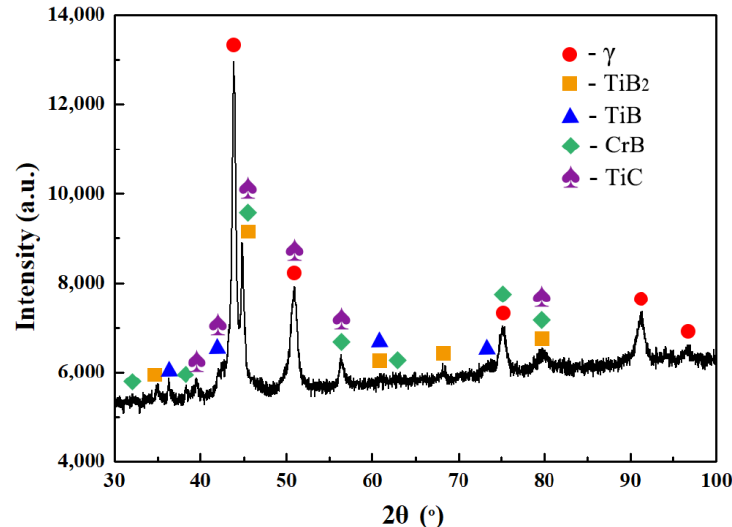
Figure 7. The XRD patterns of the representative TN15 coating.